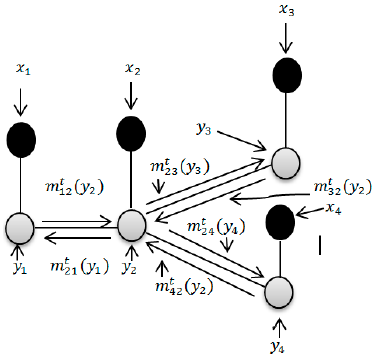
Figure 2. Message passing of LBP at t -th iteration.